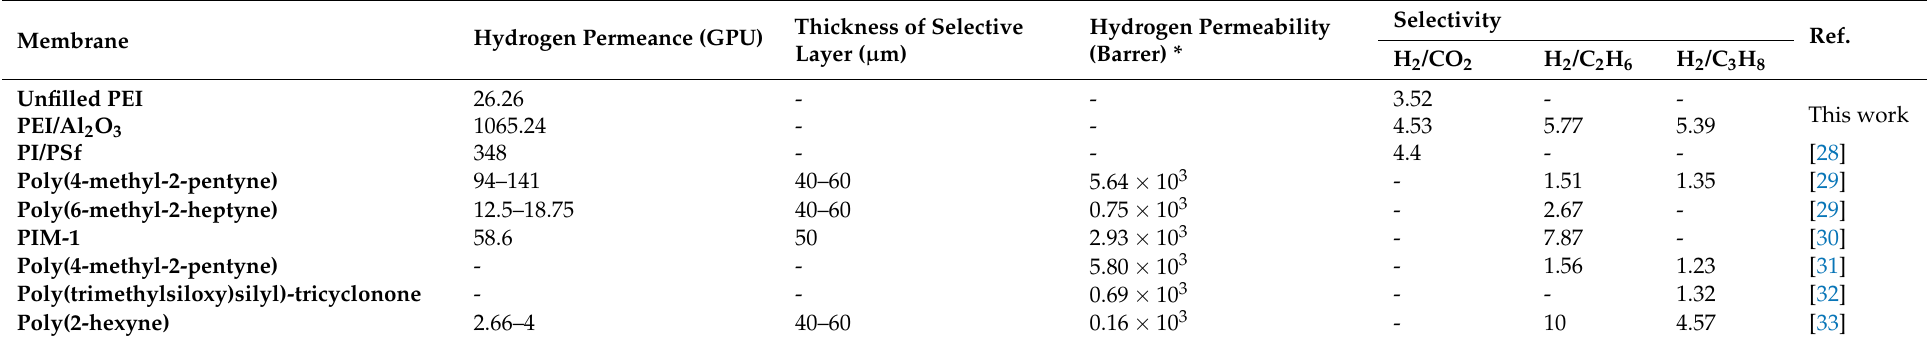
Table 4. Comprehensive comparison with other asymmetric membranes and commonly used membranes for alkane